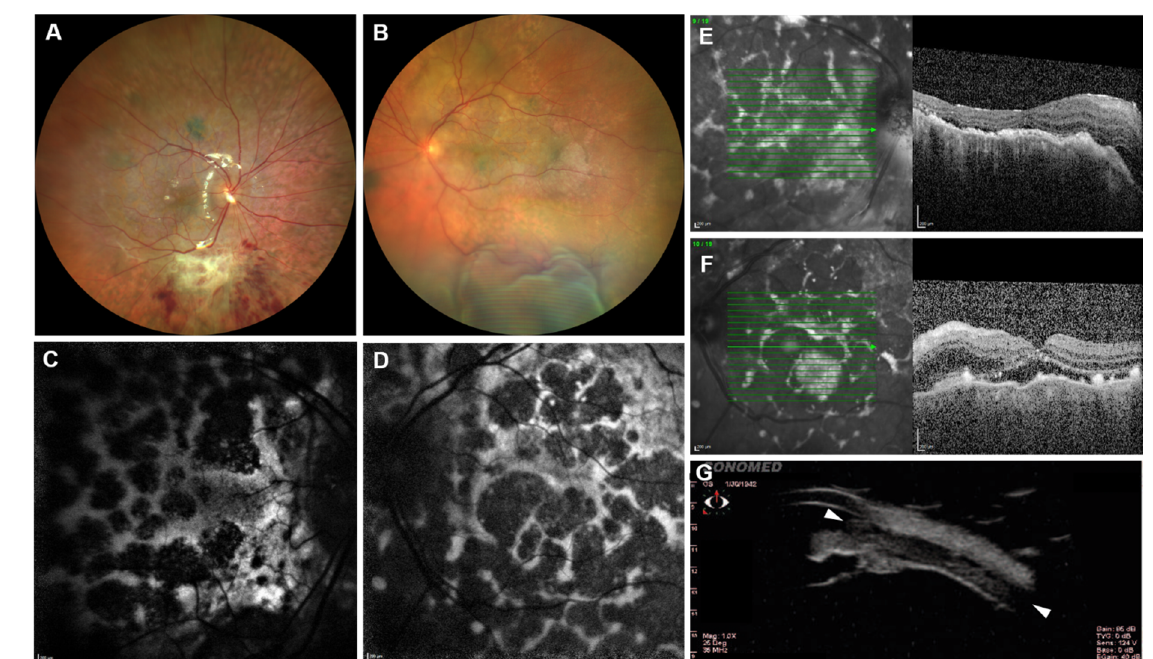
Figure 1. Ophthalmological findings. ( A ): Fundus image of the right eye at presentation, after vitrectomy and silicone oil filling. Diffuse flat, dark spots are distributed over the posterior pole. ( B ): Vitreous haze and retinal detachment in the left eye, also showing dark spots. ( C , D ): Fundus autofluorescence (( C ): right eye; ( D ): left eye) with a leopard spot pattern. ( E , F ): OCT B-scans (( E ): right eye; ( F ): left eye) reveal subretinal fluid, exudates, and distorted retinal layers. ( G ): Ultrasound biomicroscopy showing uveal swelling expanding into the anterior chamber angle (arrowhead to arrowhead).